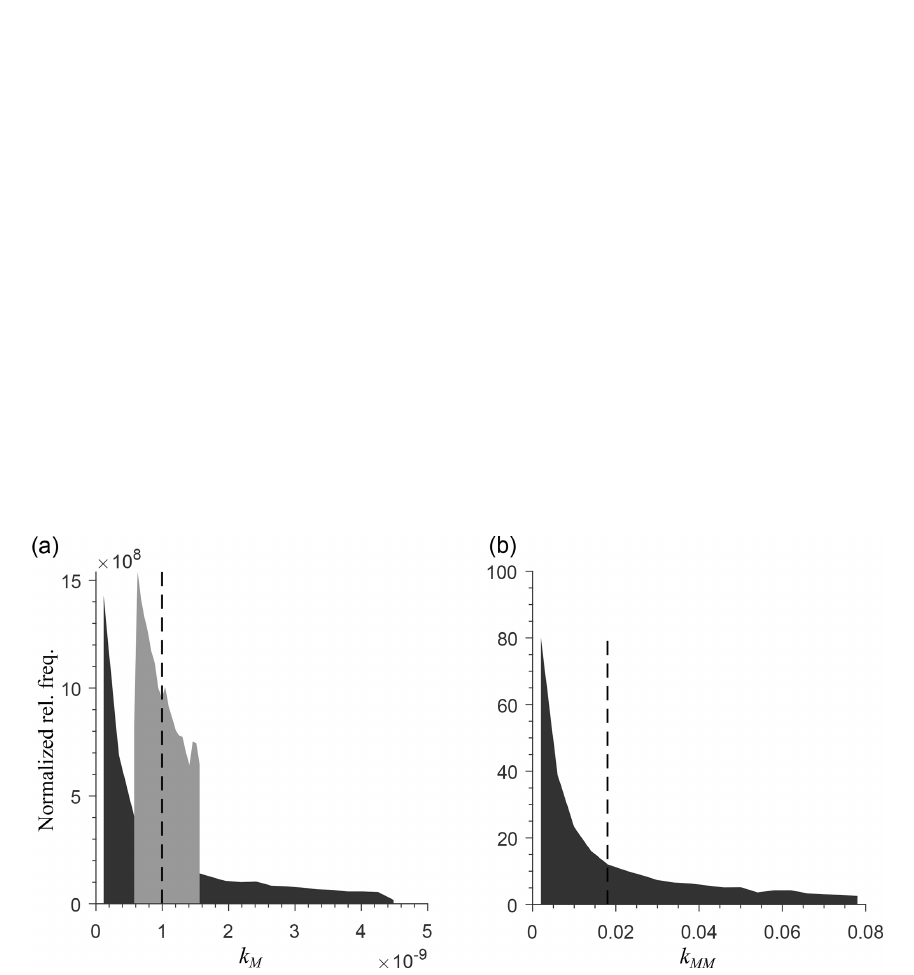
Figure A7. Distribution of the decomposition rate constant for different degrees of biochemical heterogeneity and for (a) multiplicative and (b) Michaelis–Menten kinetics. Black and grey shading represents a higher and lower degree of biochemical heterogeneity, respectively, and the dashed line represents the mean rate constant for the homogeneous system. The half-saturation constant K MM is uniformly distributed; not shown in